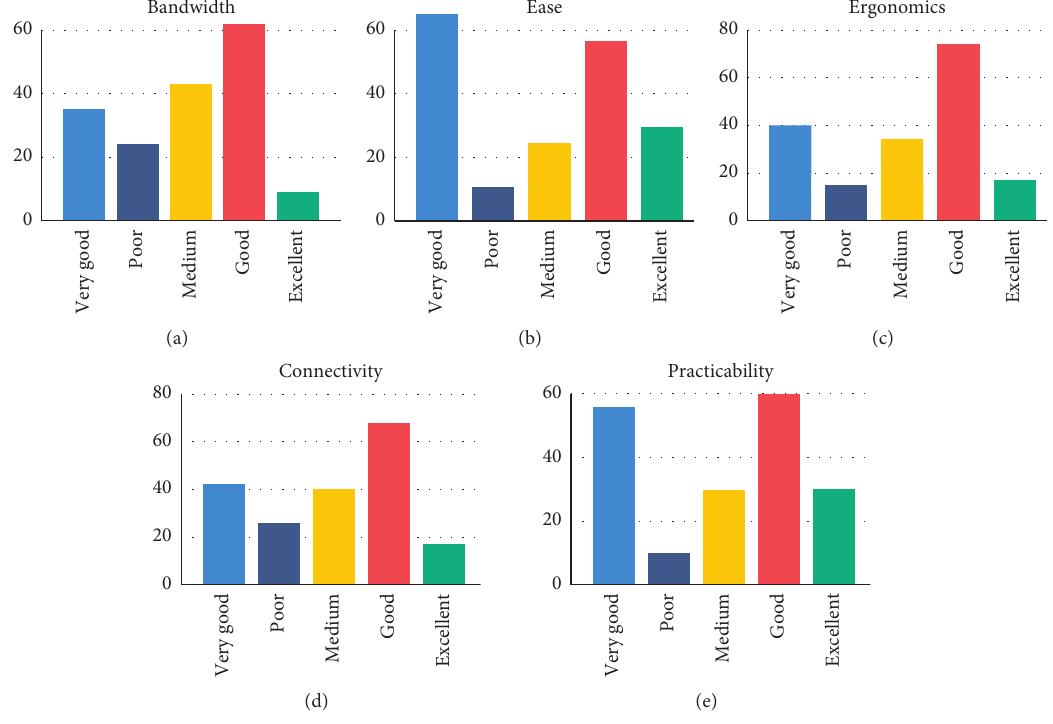
Figure 2: Platforms assessment. Table 8: Student participation rate by